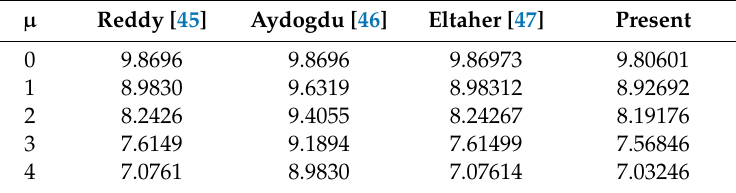
Table 2. Nondimensional buckling force for a simply supported